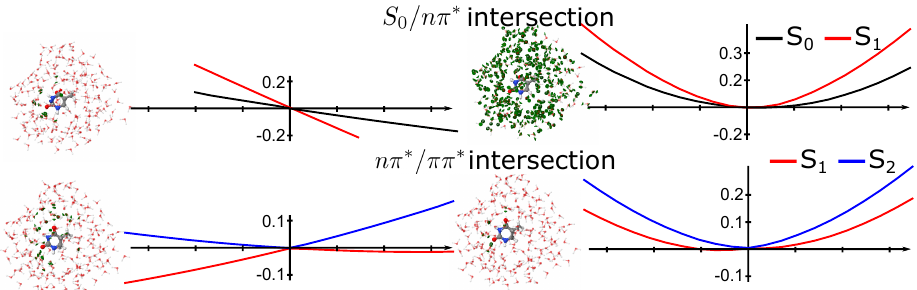
Figure 6. Topology of conical intersections of thymine in water. ( top ) S 0 / n π ∗ intersection and ( bottom ) n π ∗ / ππ ∗ intersection. Structures and graphs correspond to the gradient difference vector and the PES along that coordinate ( left ) and non-adiabatic coupling vector ( right ). The contribution of the solvent on the branching plane vectors is shown in